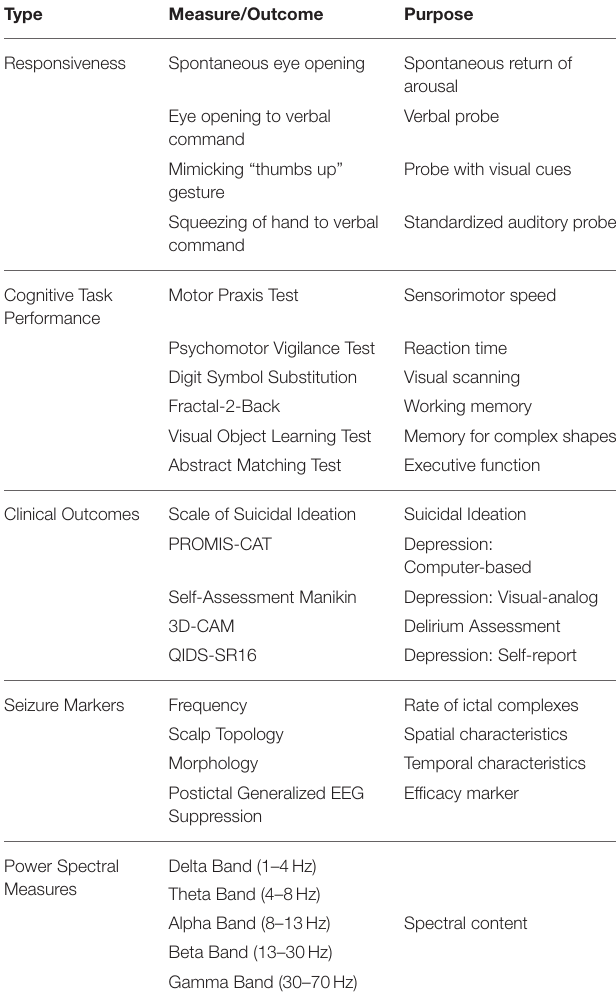
TABLE 1 | Summary of study measurements and outcomes for primary